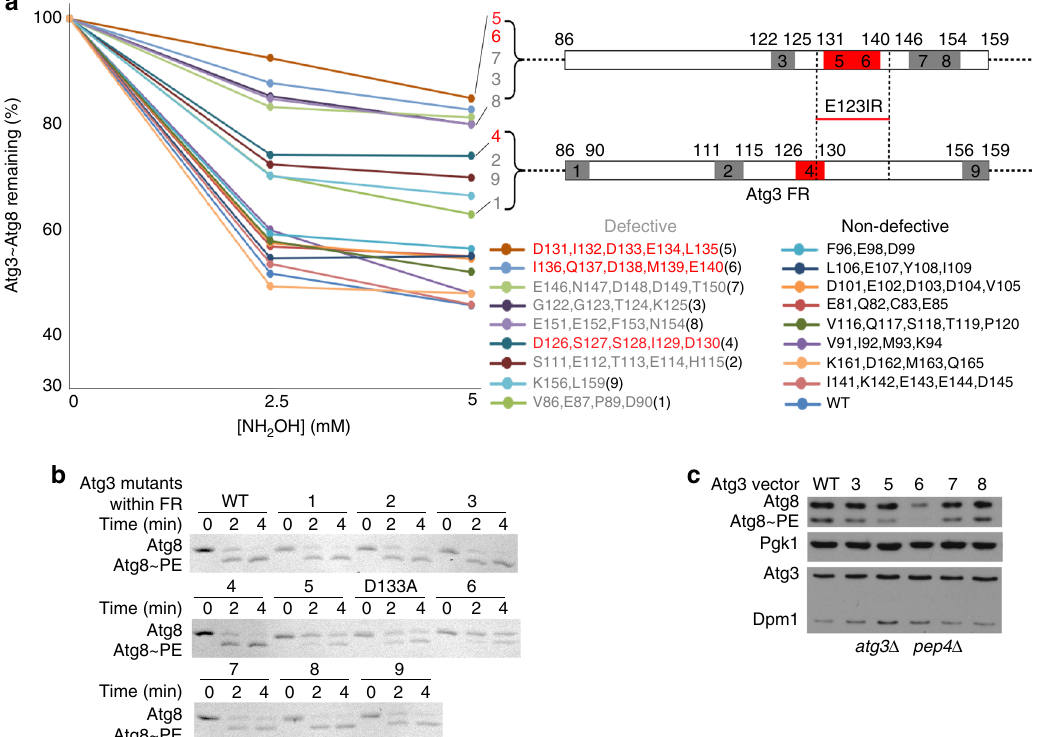
Fig. 2 E123IR plays essential role in E3-dependent Atg8 ligation activity. a Effects of indicated Ala mutants in Atg3 ′ s FR on E3 (Atg12 – Atg5-Atg16) activation of Atg3~Atg8 intermediate, quanti fi ed as percent Atg3~Atg8 remaining in pulse-chase discharge to NH 2 OH over 2.5 min. Locations of most defective and moderately defective mutants are indicated on schematics, and those corresponding to Atg3 E123IR are shown in red. b Effects of indicated Ala mutants in Atg3 ′ s FR on Atg8 lipidation in vitro, in reactions with Atg7, Atg12 – Atg5-Atg16, and liposomes generated from E. coli polar lipids as source of PE, and detected by migration of Atg8 in Coommassie-stained SDS-PAGE gel. c Effects of indicated Ala mutants in Atg3 ′ s FR on Atg8 lipidation in vivo, as detected by western blot for Atg8 after 2 h starvation of XLY161 atg3 Δ pep4 Δ strain of S. cerevisiae expressing either WT or mutant HA-tagged Atg3. Pgk1 is loading control for Atg8, Dpm1 is loading control for